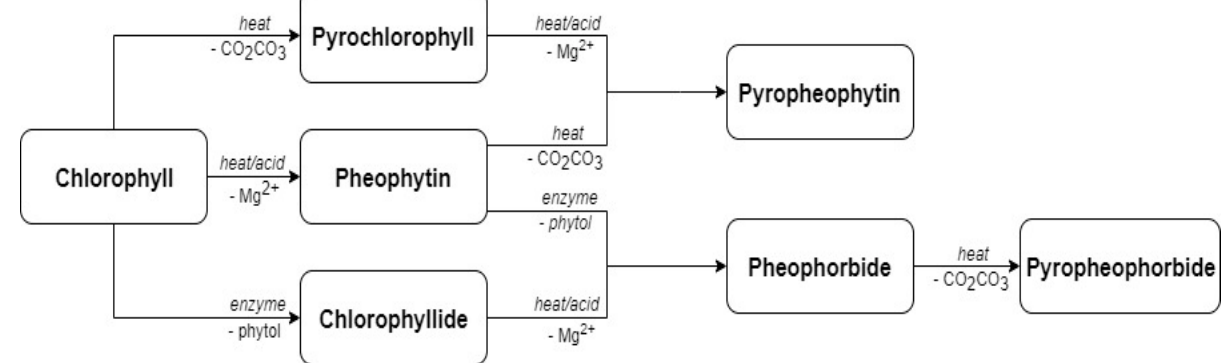
Figure 1. Chlorophyll degradation pathways .